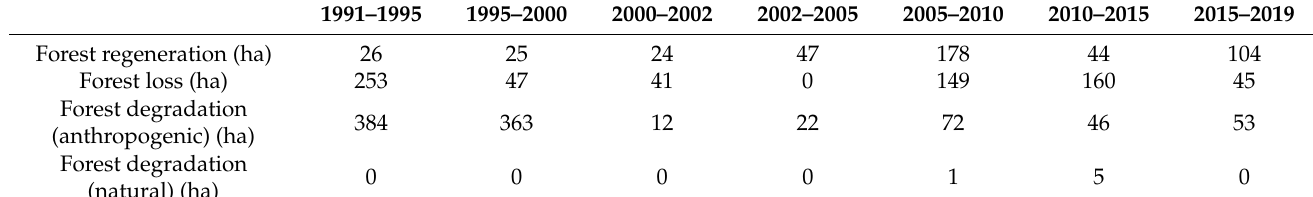
Table 4. Forest perturbation on Dilijan National Park over the 1991–2019 period.